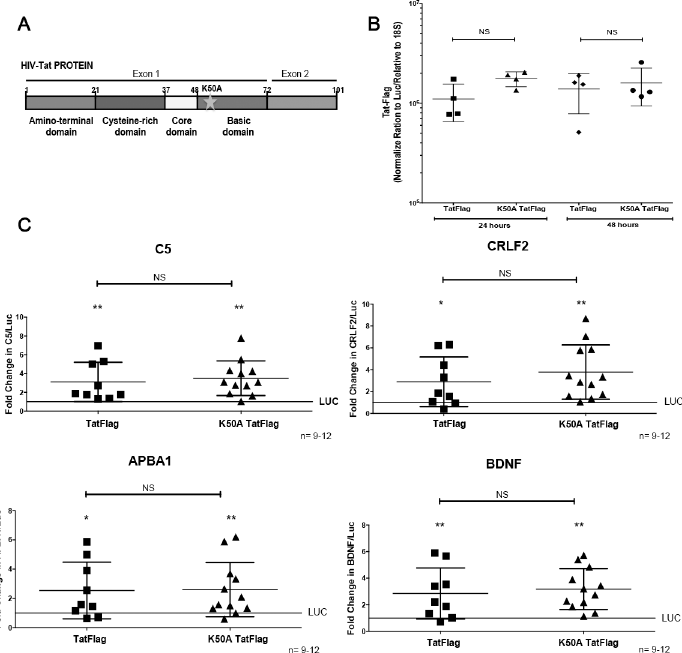
Fig 5. Tat-Flag and mutant K50ATat-Flag complex bind similarly to human C5, CRLF2, APBA1, and BDNF genes. (A) Cartoonof HIV-Tat protein illustratingthe mutation K50A. We infected THP-1 cells with a lentiviruswith this mutation to generatestable cells that express K50ATat-Flag. (B) Expression of Tat-Flag and K50ATat-Flag at 24 and 48 hours was analyzedby qRT-PCR. THP-1Tat-Flag cell lines generatedfrom 5–6 independent sets of infection and selection,and THP-1TatK50ATat-Flag cell lines generatedfrom 2 independent sets of infection and selection,were differentiated to macrophages with PMA for 24 and 48 hours. Total RNA was extracted and cDNA was generated.The target mRNA levels were normalized to 18S using the method of Pfaffl. We found similar expressionof Tat-Flag and K50ATat-Flag genes. (C) THP-1Tat- Flag and THP-1Tat K50ATat-Flag cell lines were treated with PMA for 24 hours, cell lysates were prepared and immunoprecipitatedwith antibody to Flag, followedby qPCR analysis. For qPCR analysis, we used the specific sequencesin the genomeidentifiedby ChIP-seq and we designedspecific primers for these regions for the 4 genes, C5, CRLF2, APBA1, and BDNF. The precipitated DNA and input were quantifiedby real-time PCR. Quantification is expressedin arbitrary units indicatingfold change over control (Luc), and target sequencelevels were normalized to the input using the method of Pfaffl. No significantdifferences were found betweenthe association of Tat-Flag and K50ATat-Flag to the 4 genesselected. Significance was determined using a Wilcoxon signed-ranktest. Error bars represent the median ± S.D.; * P < 0.05, ** P < 0.01. For comparisonbetweenTat-Flag and K50ATat-Flag gene expression, Mann-Whitney tests were performed. Error bars represent the median ± S.D., ns: not